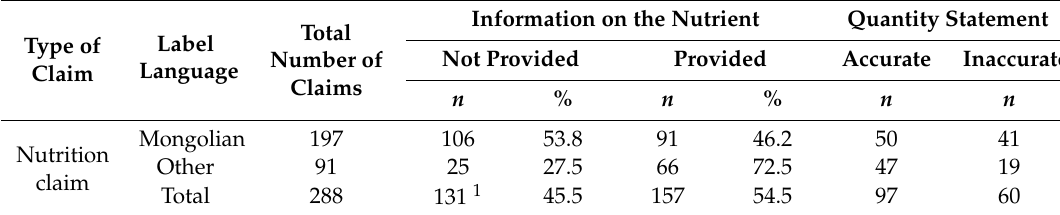
Table 4. Credibility of nutrition claims by label language.